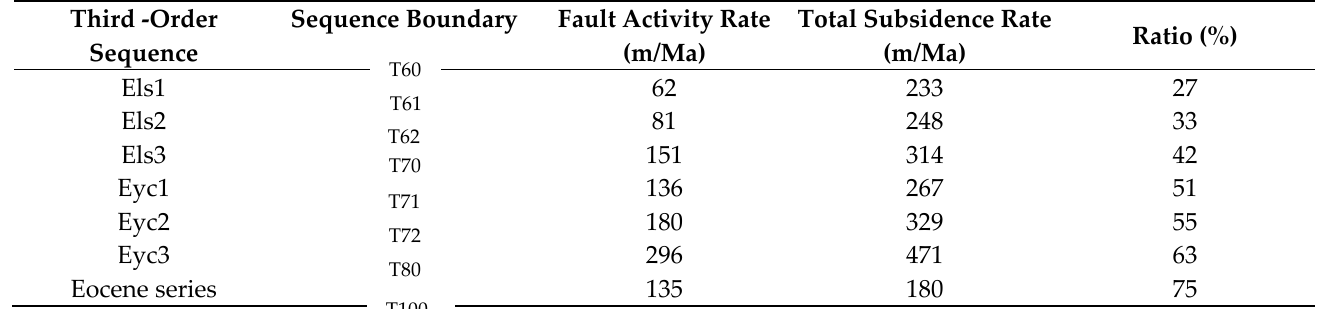
Table 2. The ratio of the fault activity rate to the total subsidence rate (the data for total subsidence was drawn from Song et al., 2020b [37]).